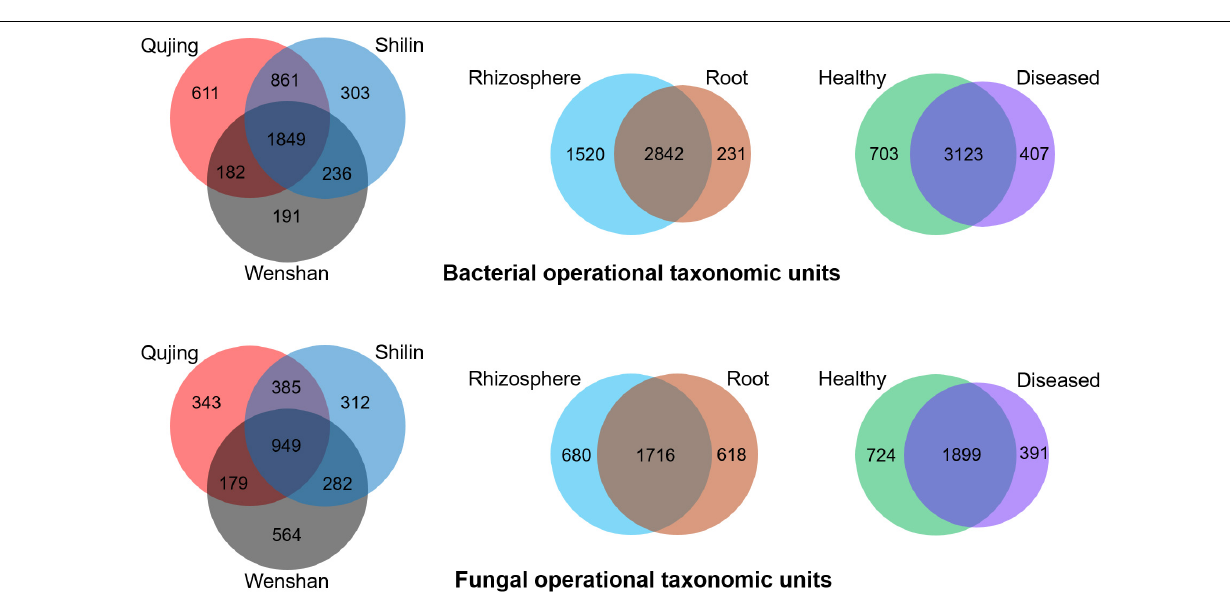
Actinobacteriota, Bacteroidota, Cyanobacteria, Crenarchaeota, Chloroflexi, Gemmatimonadetes, Firmicutes, Proteobacteria, Unidentified_Bacteria, and others ( Figure 5A ). The